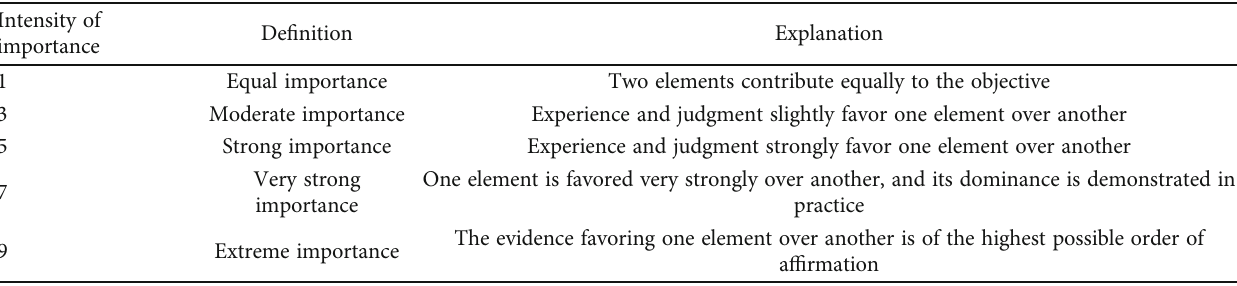
Table 3: The comparison scale in AHP intensity [117, 119].